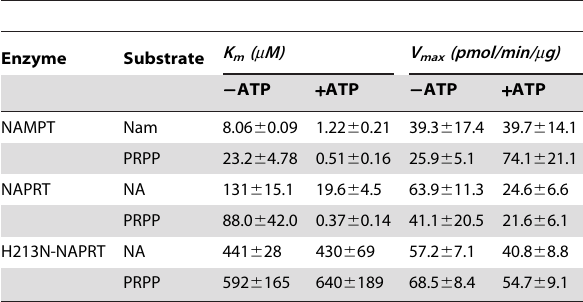
Table 1. Kinetic parameters in the NAMPT and NAPRT reactions.